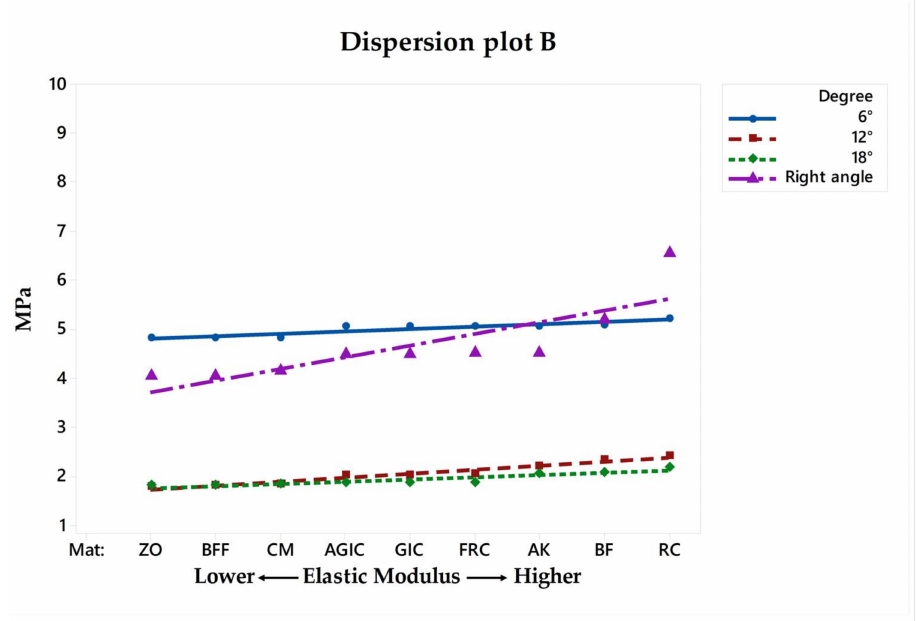
Figure 5. Dispersion plot according to the filling material elastic moduli and stress peaks recorded on the cement